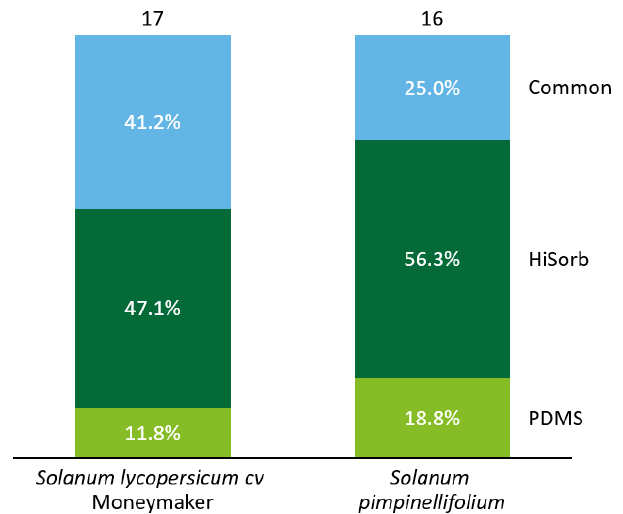
Figure 1. Percentage of volatile compounds detected from roots of wild ( S. pimpinellifolium ) and do- mesticated ( S. lycopersicum ) tomato by two different trapping materials (HiSorb and PDMS). From top to bottom: total number of volatile compounds detected, percentage of volatile compounds detected commonly by both trapping materials (Common), exclusively detected by HiSorb or exclusively detected by PDMS.